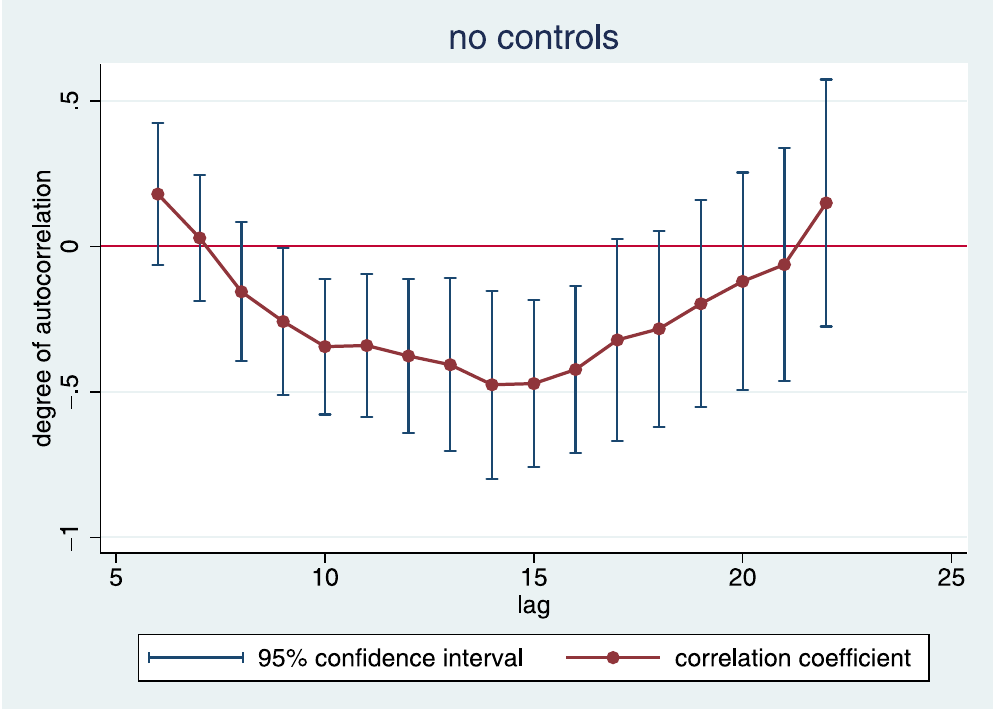
Fig 4. Autocorrelation (absent controls). Dots are coefficients of the lag of the number of habilitations x years ago from regression (1), bars represent the standard error of this regressor.